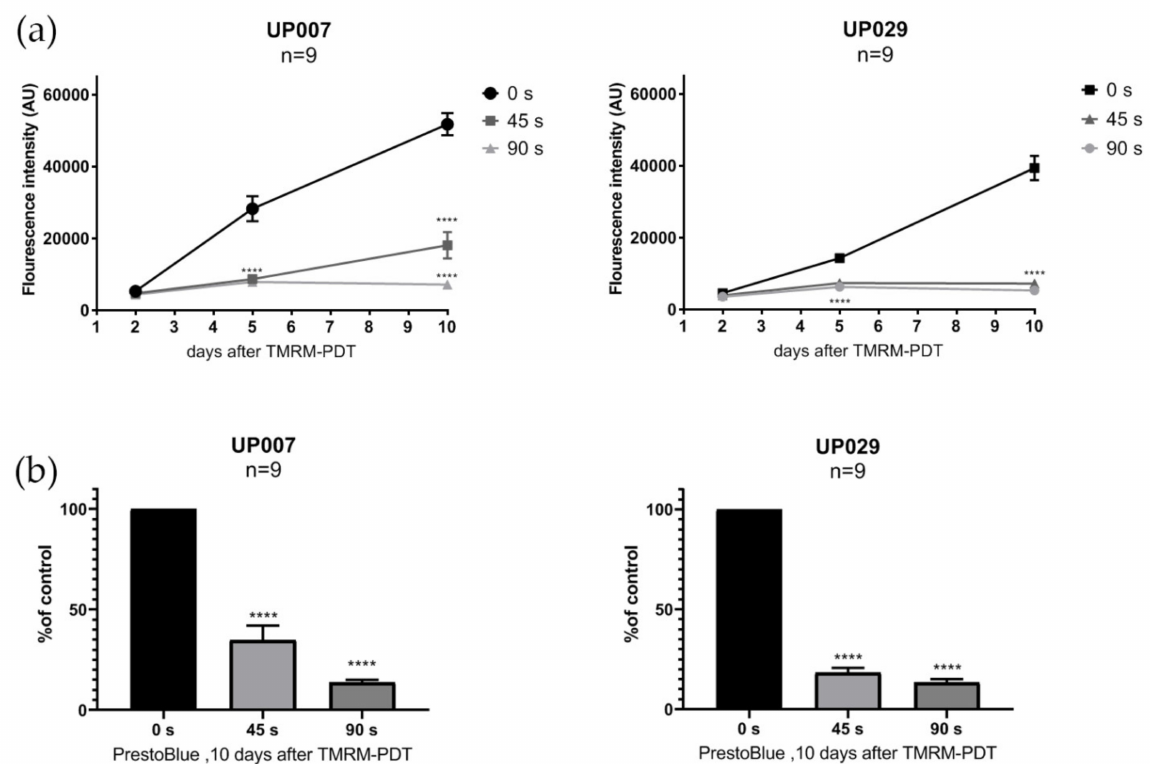
Figure 9. Lasting effects of TMRM-PDT. ( a ) Single episode of TMRM-PDT permanently affected the viability of GBM cell lines (PrestoBlue assay). GBM lines were photoactivated for 0 s, 45 s or 90 s after being loaded with 300 nM TMRM. N: is the total number of datapoints from 3 independent experiments. (****) p value < 0.0001. Data are given as the mean ± SEM. ( b ) Effect of varying light exposure on cell viability assessed 10 days after TMRM-PDT, Presto Blue assay. (****) p value <